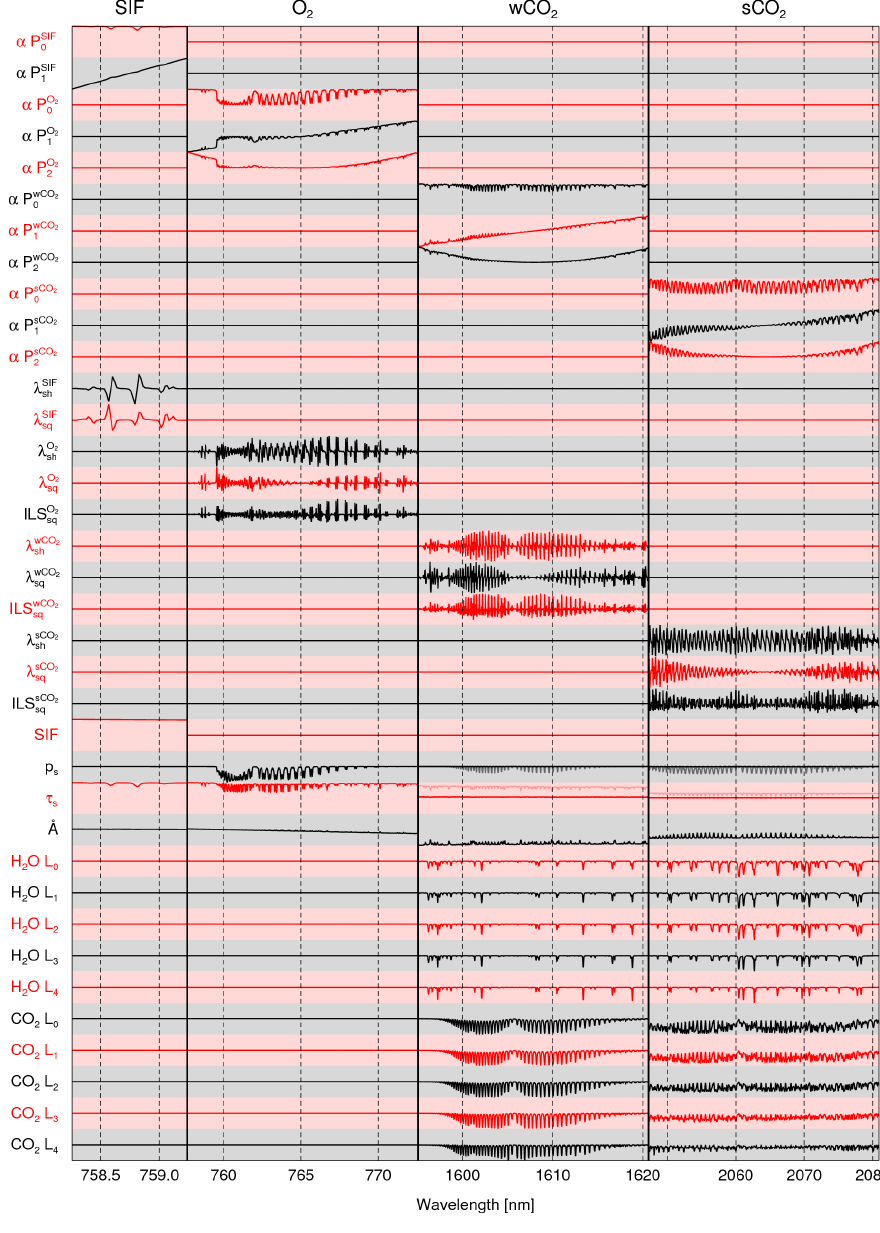
Figure 6. Jacobian matrix computed with FOCAL for the geophysical Rayleigh scenario and the 3-Scat retrieval setup. Within the CO2 fit windows, an additional line in light colors shows the partial derivatives according to τ s and p s scaled by a factor of 10 and 20,